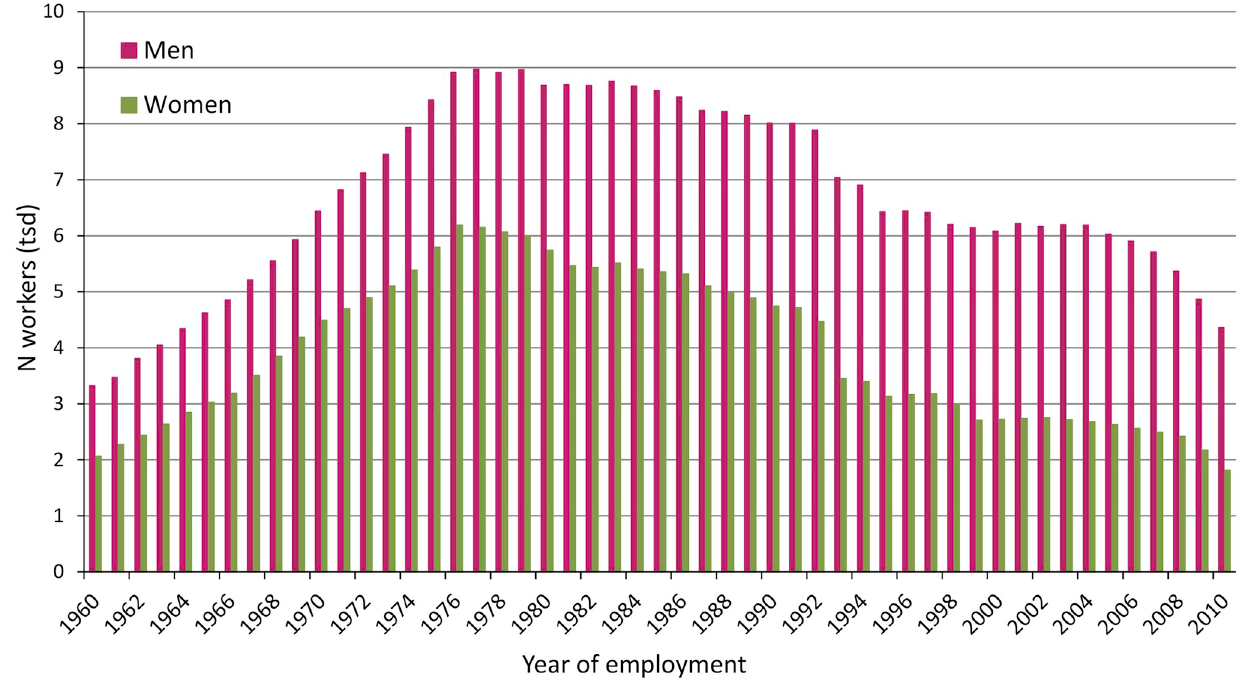
Fig 3. Number of active workers in thousands (tsd) by year in the Asbest Chrysotile Cohort